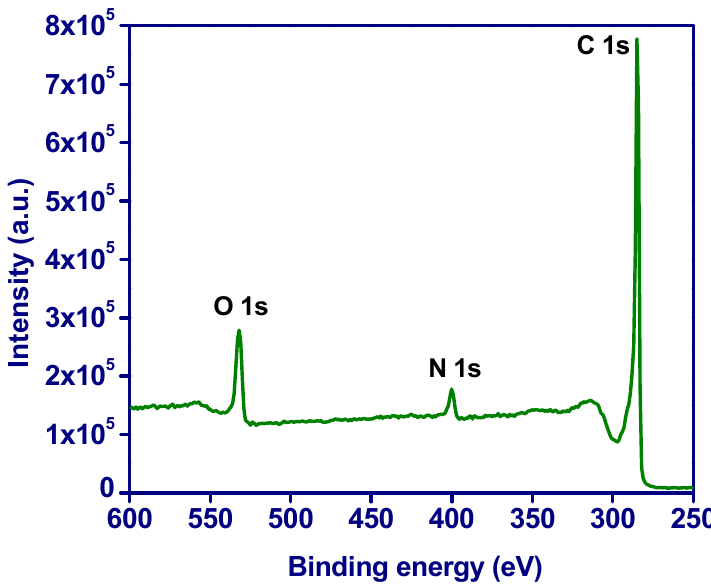
Figure 4. XPS full scan image of NDG.